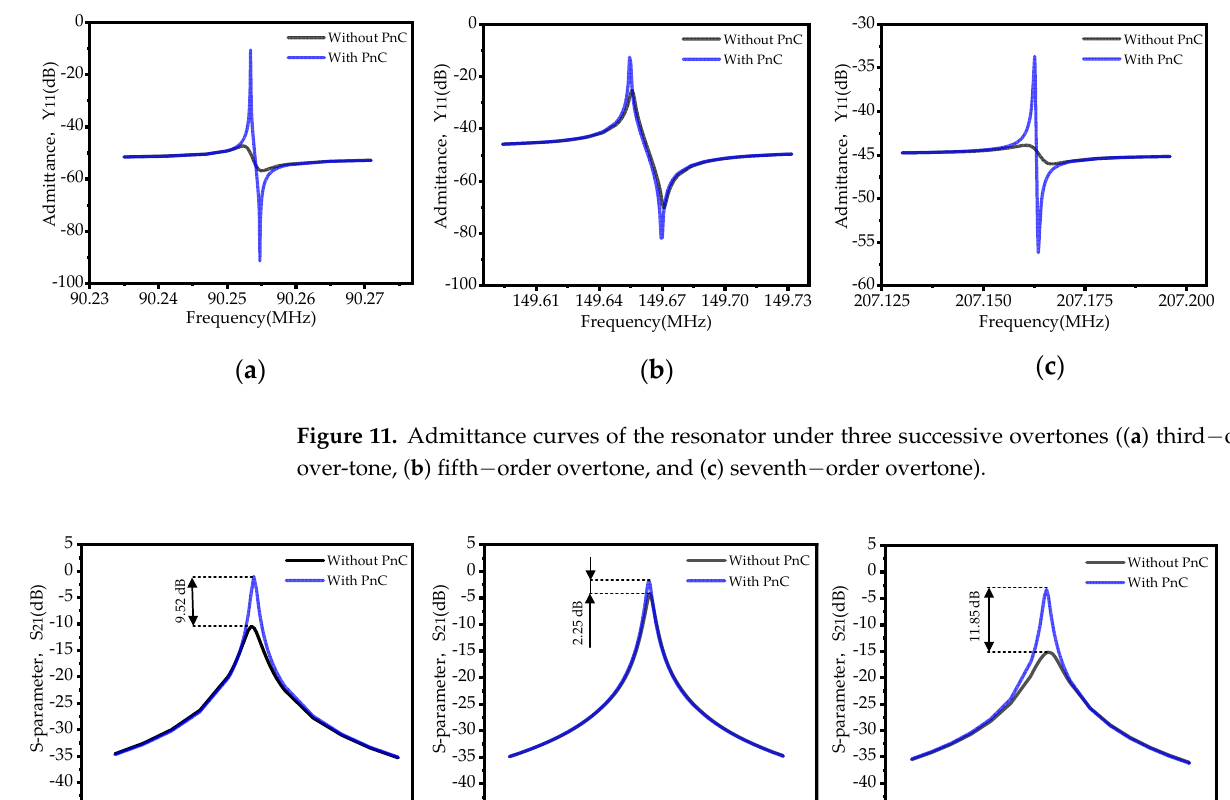
Figure 10. Illustration of the total displacement ( μ m) for the conventional resonator and the resona ‐ tor with the SCC ‐ PnC plate for the ( a ) 3rd, ( b ) 5th, and ( c ) 7th order width ‐ extended modes on line A ‐ A, respectively. where ∆ f − 3 dB is − 3 dB band width and IL is insertion loss.